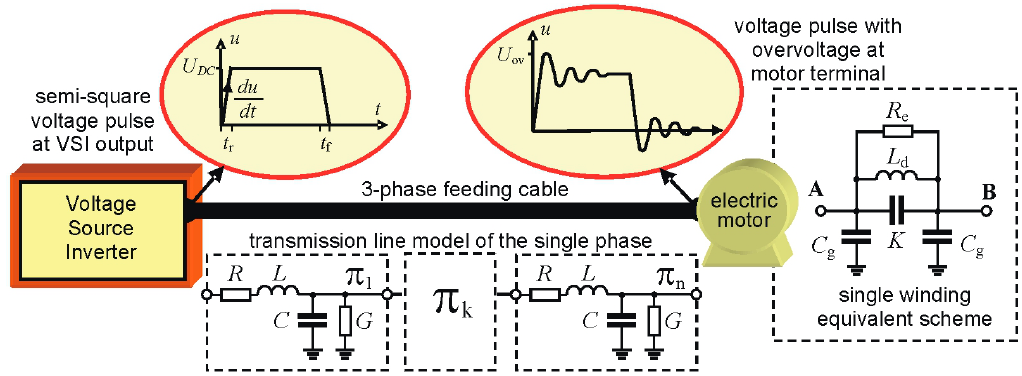
Figure 2. A basic setup of induction motor connected to voltage source inverter by feeding cable: R , L , C , G — π -section parameters of cable phase, L d —inductance of winding, C g —distributed ground capacitance, R e —resistance representing losses, K —input winding capacitance; U DC —inverter DC-link voltage, U ov —maximum value of overvoltage at motor terminal, d u /d t —slew rate of impulse voltage, t r —voltage pulse rise time, t f —voltage pulse fall time.